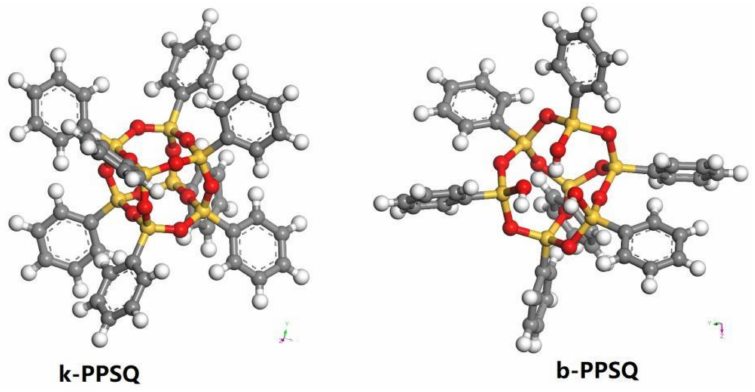
Figure 1. Two different structures of